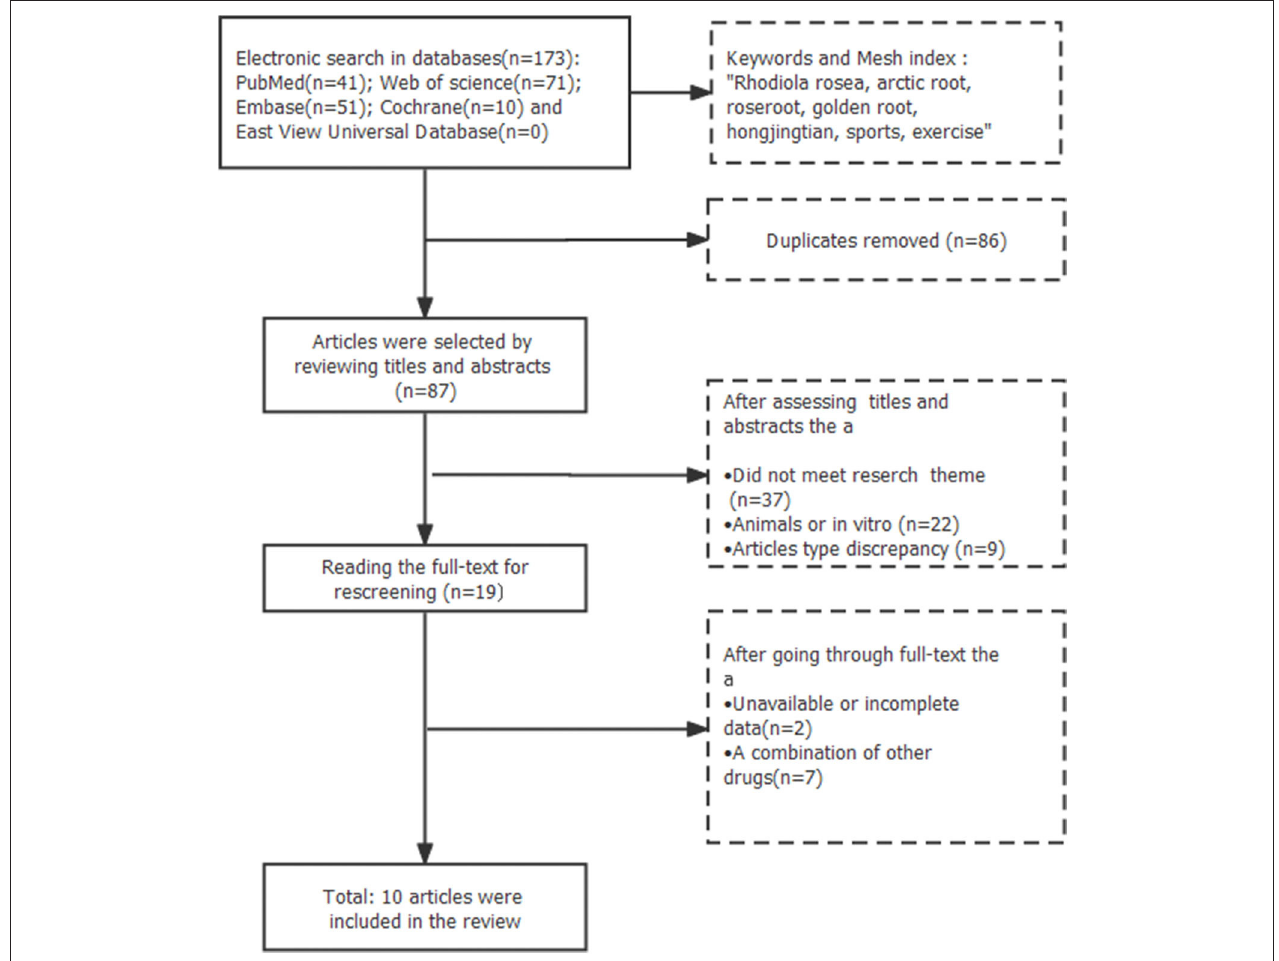
FIGURE 1 | Literature screening